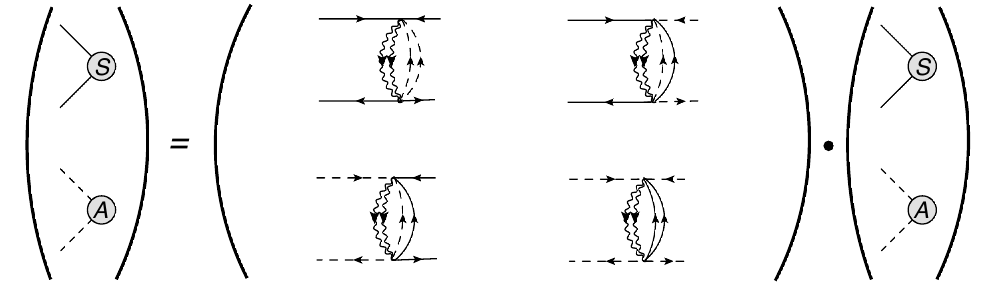
Figure 8 . Schematic form of the eigen-equations associated to the kernels of the 4-point func- tions in the model (4.1). There is another similar equation with the symmetry properties of the eigenfunctions